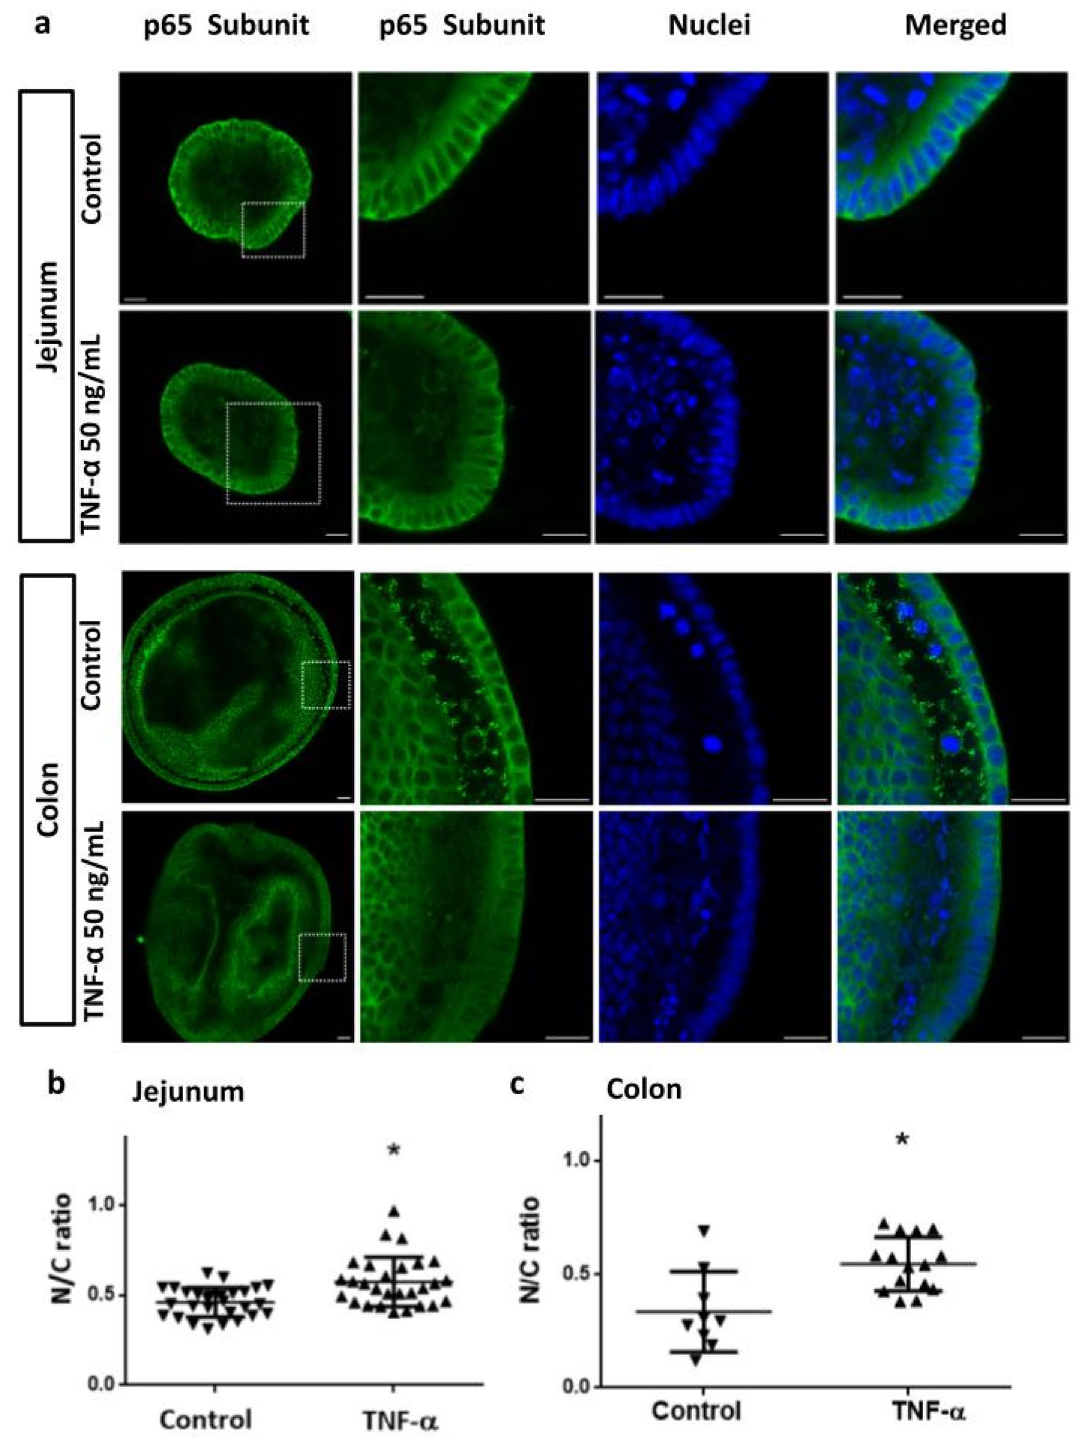
Figure 5. TNF-α induces NF-κB translocation into the nucleus of intestinal organoids. Organoids derived from jejunum and colon were stimulated with TNF-α (50 ng/mL) during 3 h. Unstimulated organoids were used as control. NF-κB was detected by using an anti-p65 antibody (green). Nuclei were stained with methyl green (blue). In both stimulated organoids, the NF-κB signal was more homogeneously distributed between nucleus and cytoplasm compared to the controls, where non-labeled nuclei predominate ( a ). Nuclear translocation of NF-κB was quantified using the green signal intensity ratio between the nuclei and the cytoplasm (N/C ratio) ( b , c ). Individual values in the graph represent one organoid measurement. Scale bar = 20 µm. Data was expressed as mean ± SD. * P < 0.05, significant differences with respect to the unstimulated